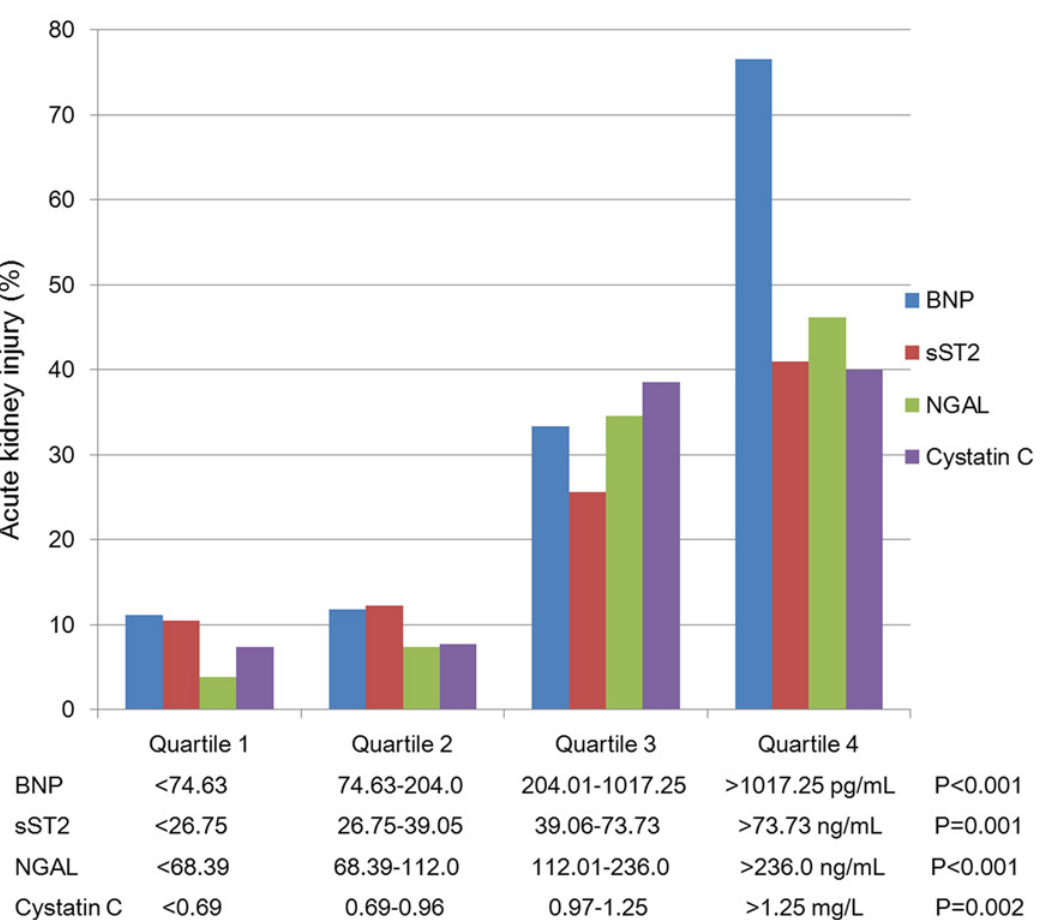
Fig 2. Serum levels of the biomarkers at presentation and the risk of developing acute kidney injury within 48 hours. The risk of developing acute kidney injury at 48 hours increased significantly as serum levels of biomarkers rose at presentation.